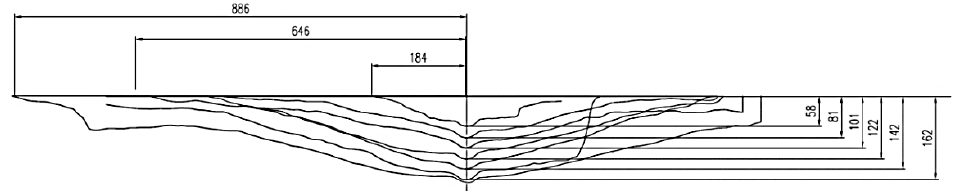
Figure 13. Typical crack propagation for a single-anchor fastener, depending on the effective